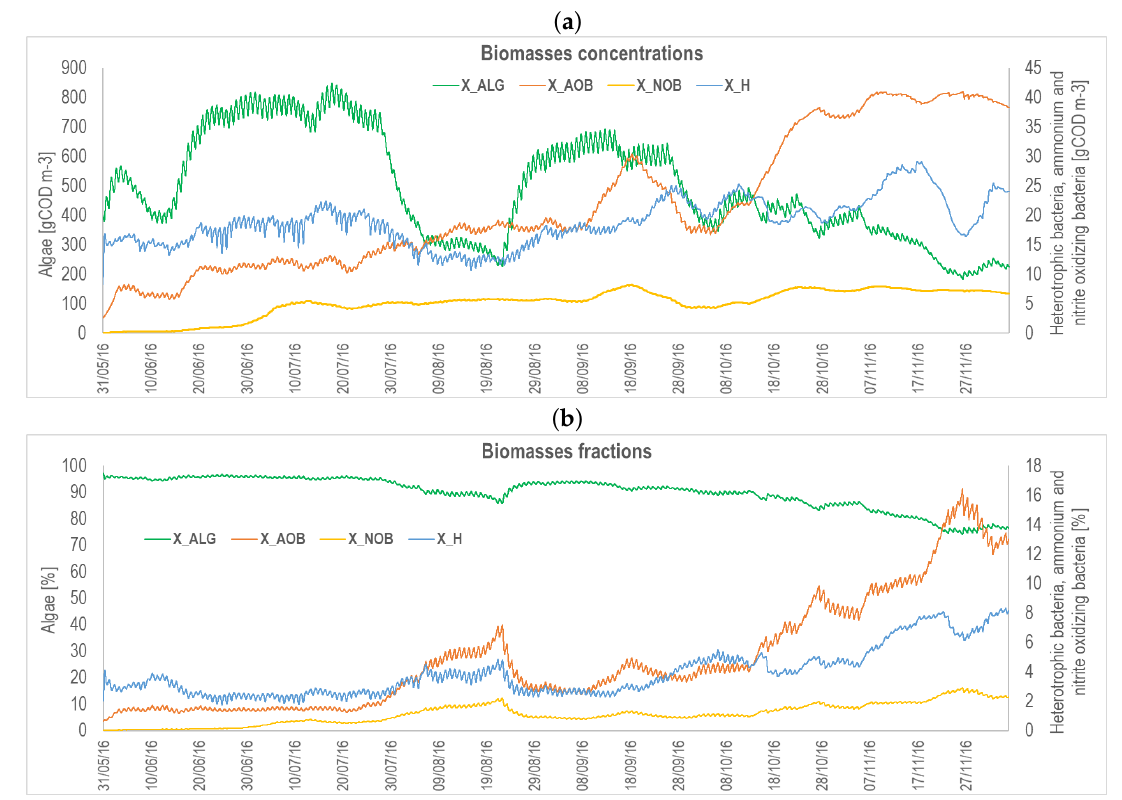
Figure A9. Ecosystem composition during the experimental campaign carried out in the north of Italy: ( a ) expressed in concentration (gCOD m − 3 ); ( b ) expressed in percentage (%). Algae are reported on the left axis, while heterotrophic and nitrifying bacteria are on the right axis, in both figures ( a , b ). Simulations are from May to November